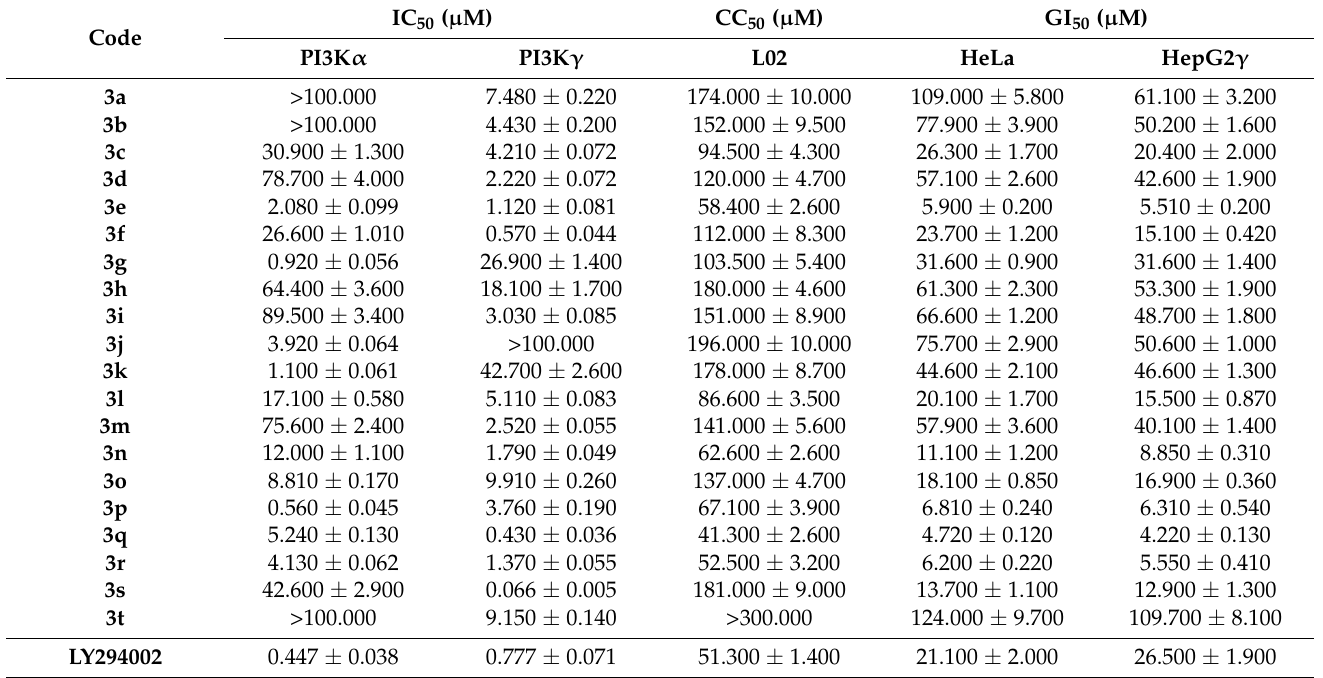
Table 1. The PI3K inhibition, cytotoxicity, and anti-proliferation activity of the synthesized com- pounds 3a-3t